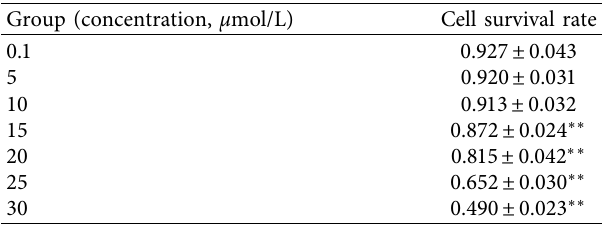
Table 1: Effect of emodin with different concentrations with MTT method on the survival rate of HUVECs ( n � 3, x ± S ).